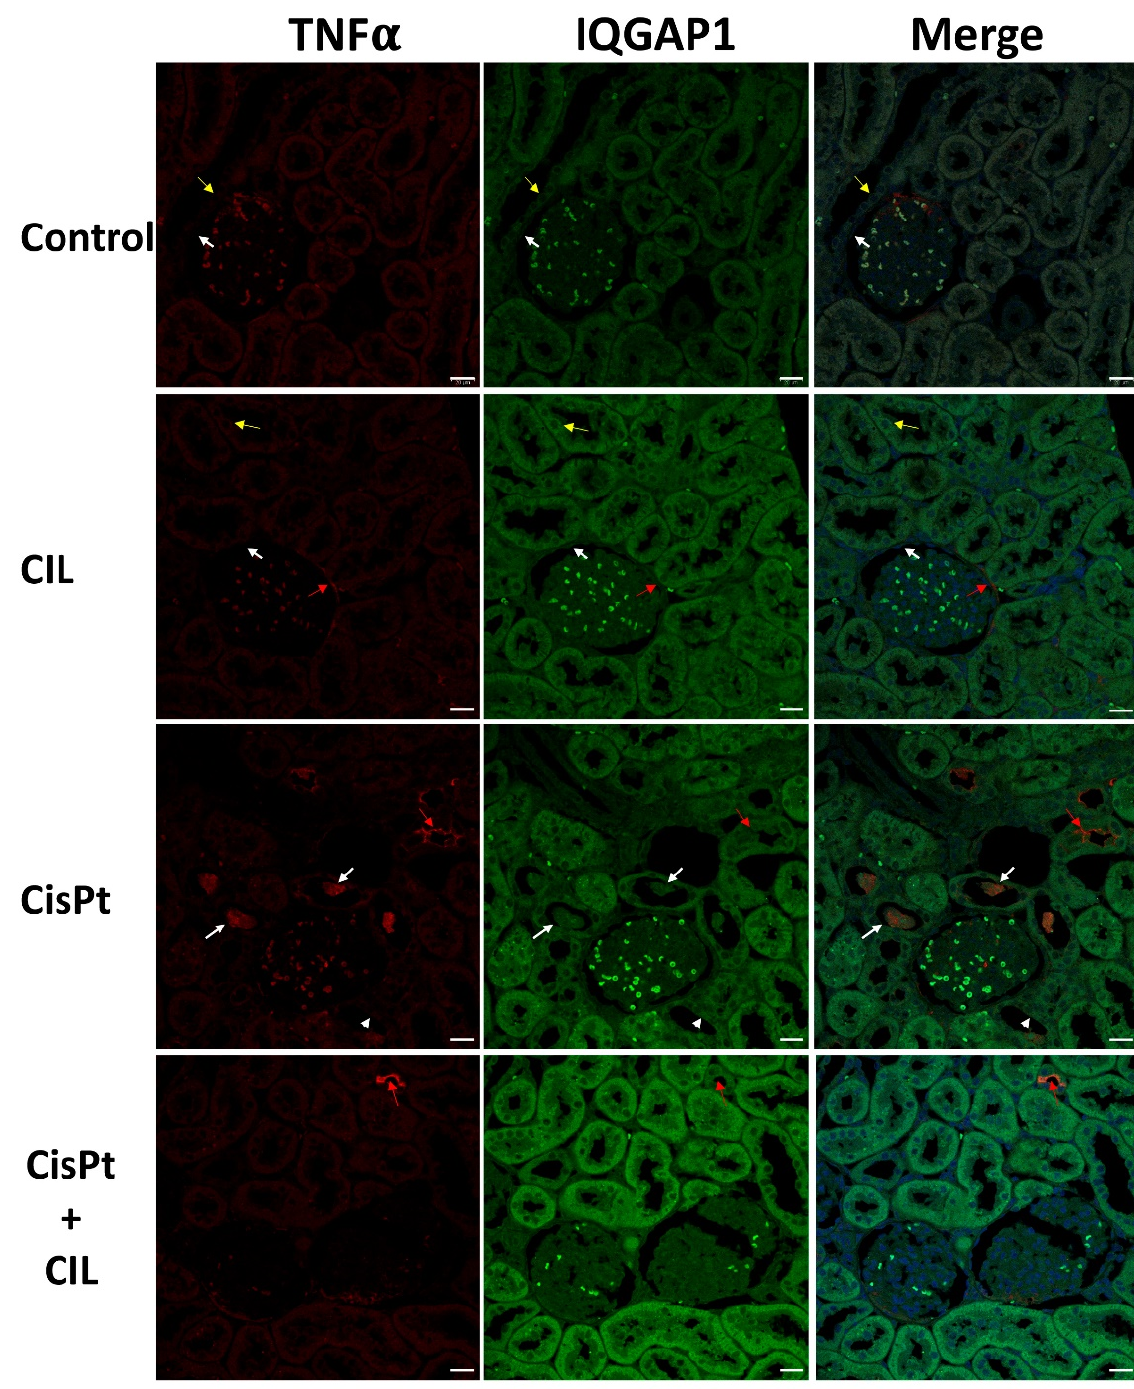
CisPt panels: bold white arrows point to high-intensity TNF α -specific immunostaining in some tubule cells of cisplatin-treated rats; thin white arrows point to other cells within the same tubules with a lower staining intensity. In both cases intensity is higher at the apical brush border than in the cytosol. AmotL2/TNF α positive cells can be seen in the outer glomerular capsule (white arrowheads). AmotL2 fluorescence is lower in highly TNF α -positive cells. CisPt + CIL panels: kidney tubule cells of cilastatin-protected cisplatin-treated rats show a staining pattern very similar to that of controls, although both TNF α and AmotL2 signals are at a slightly lower intensity than in controls. 40 × magnification. Bar = 20 µ m.